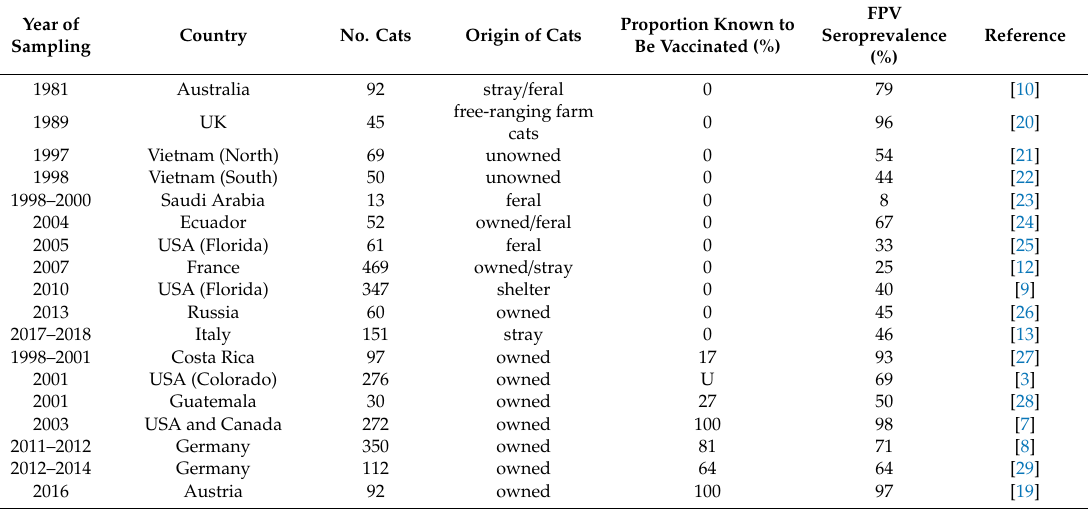
Table 4. Seroprevalence of protective serum antibody titres against FPV in domestic cats from di ff erent geographic